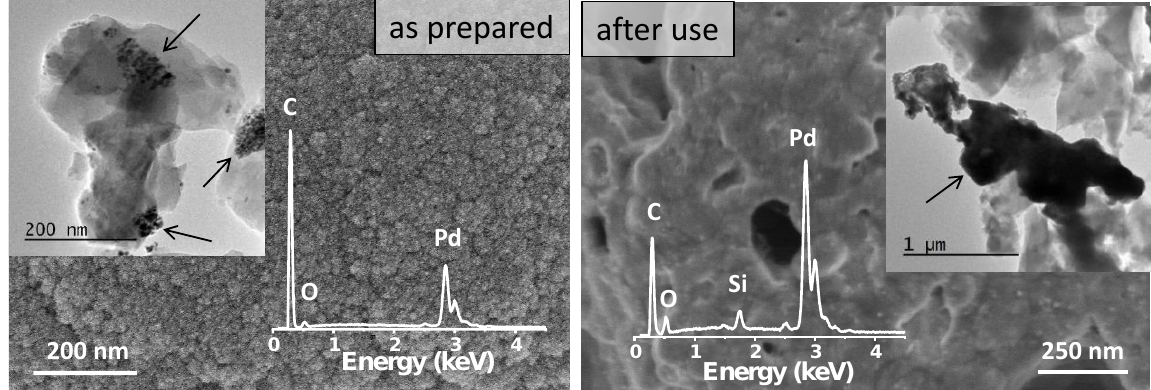
Figure 8. SEM and TEM images and SEM-EDX analysis showing the effect of catalytic tests on the 65C thin film. Catalytic films are indicated by arrows in the TEM images.